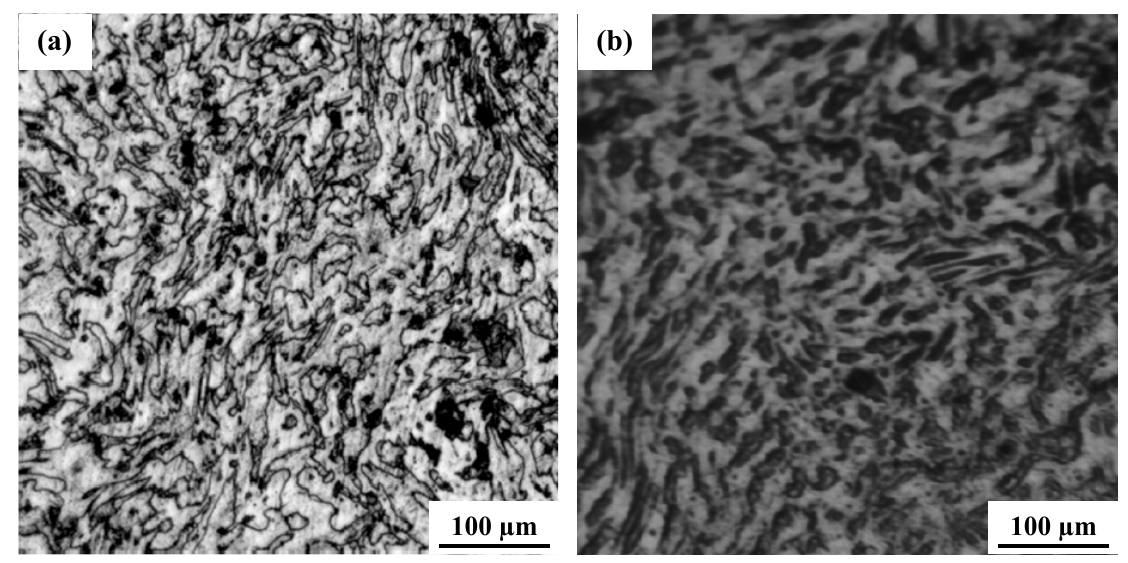
O particulates and micron size nickel 2 3